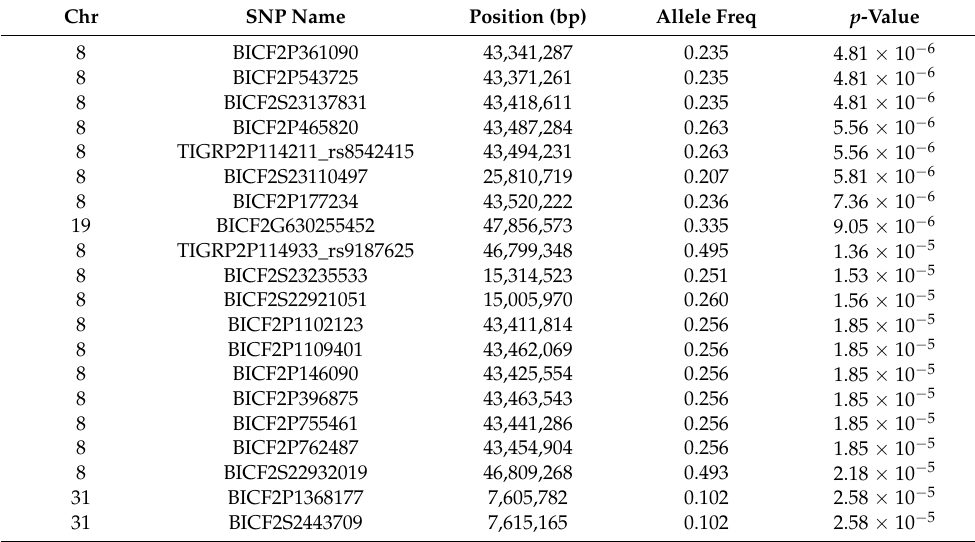
Table 3. Quantitative GWAS results showing associations with six phenotypic categories. Chromo- some (Chr), SNP name, position (bp), allele frequency, and raw p -value for the top twenty SNPs. No variant reached the significance cut-off, and thus these variants are considered suggestive